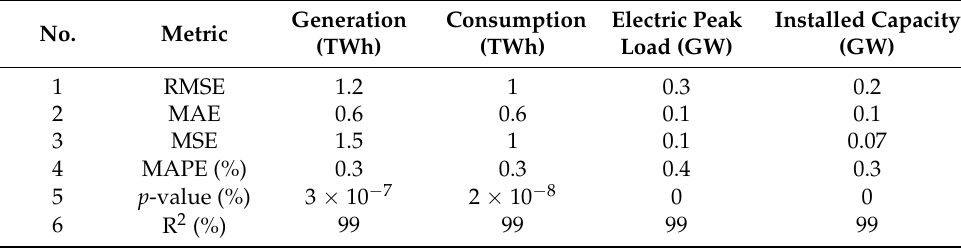
Table 1. Forecasting accuracy indicators for the proposed SARIMAX